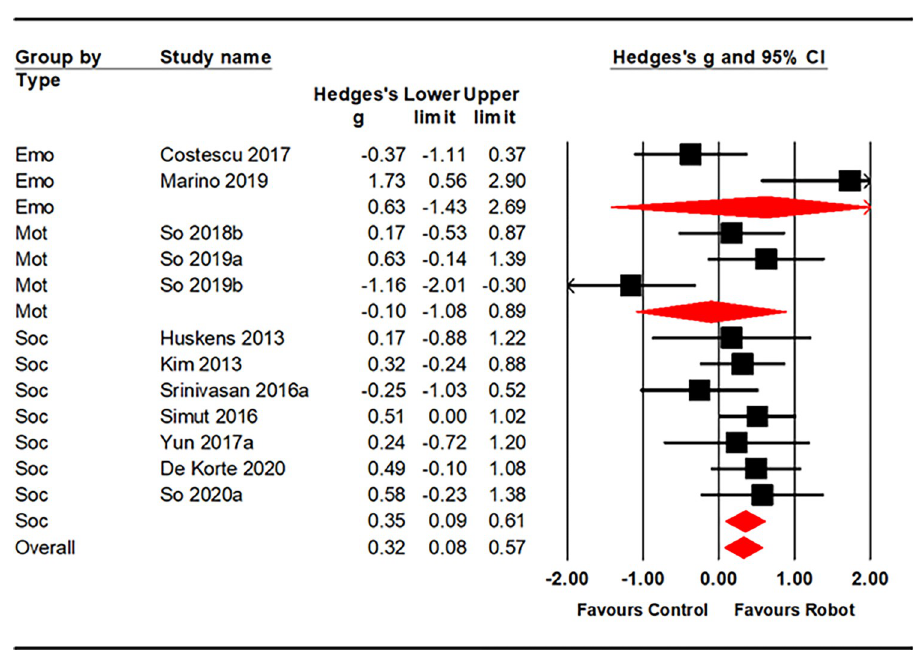
Fig 2. Forest plot showing efficacy of robot intervention on emotional, motor and social outcome